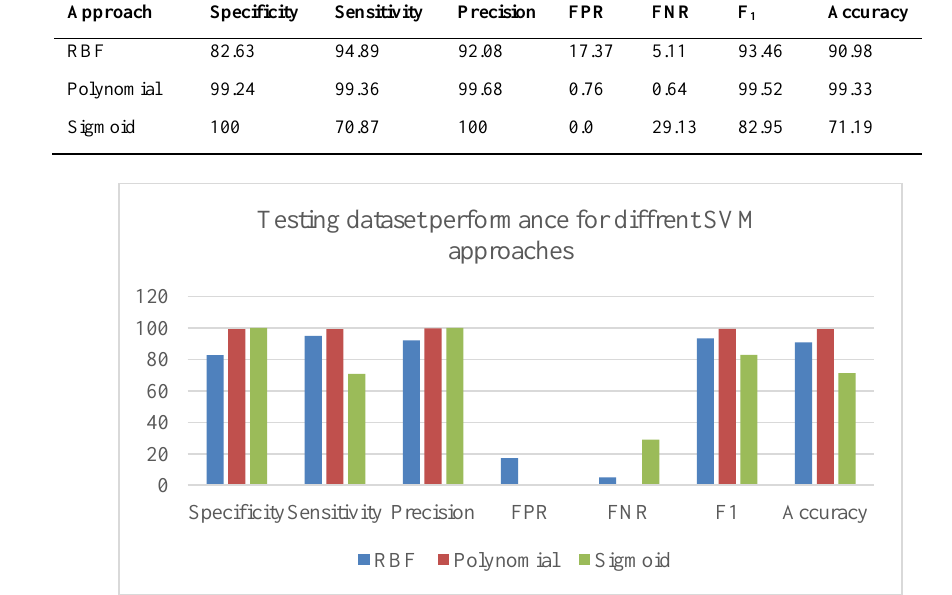
Figure 7. Performance of SVM with various approaches in testing